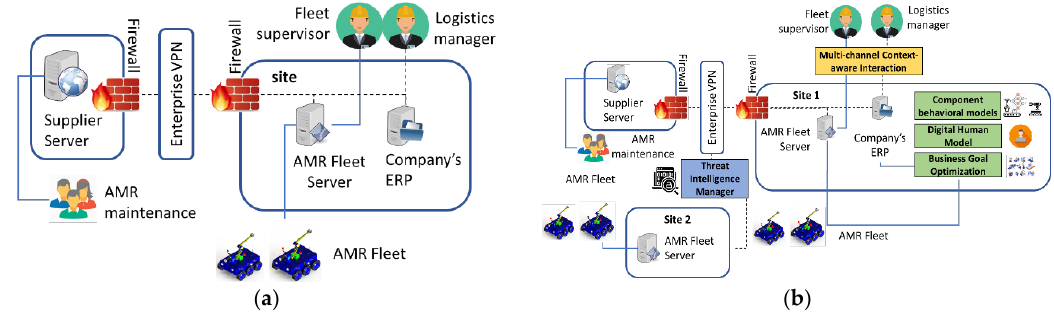
Figure 3. Current ( a ) and system-enhanced ( b ) autonomous mobile robots (AMR) production